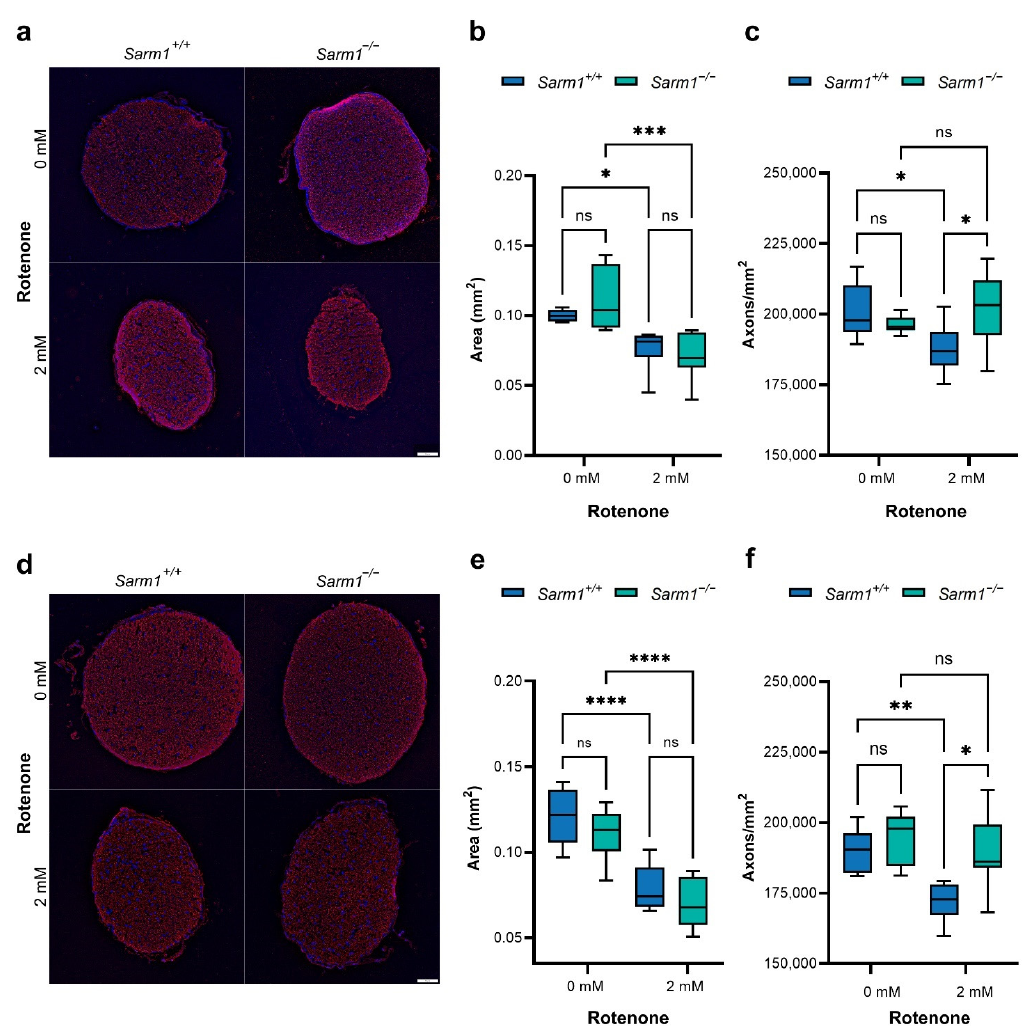
Figure 4. Quantification of axons. Two months after intravitreal injection of rotenone, eyes were enucleated, fixed and dissected. Optic nerves were cryosectioned (7 µ m) and stained for NF200 (red). Nuclei were stained with DAPI (blue). Segments of the proximal ( a ) and distal ( d ) optic nerve, the portion of the nerve nearest the eye and brain respectively, were sectioned and analysed separately. Scale bars ( a , d ) = 50 µ m. ( b , c , e , f ) Axons and optic nerve area were quantified using Olympus CellSens software. Optic nerves were thinner following rotenone insult in both genotypes ( n = 6–10), both close to the eye (( b ); Sarm1 +/+ 0.10 ± 0.004 mm 2 vs. 0.07 ± 0.02 mm 2 , p < 0.05; Sarm1 − / − 0.11 ± 0.02 mm 2 vs. 0.07 ± 0.02 mm 2 , p < 0.001) and brain (( e ) Sarm1 +/+ 0.12 ± 0.02 mm 2 vs. 0.08 ± 0.01 mm 2 , p < 0.0001, Sarm1 − / − 0.11 ± 0.02 mm 2 vs. 0.07 ± 0.01 mm 2 , p < 0.0001). Density of axons was protected in Sarm1 − / − optic nerves, with no significant difference between insulted and non-insulted sections from proximal (( c ) 201,631 ± 12,619 axons/mm 2 vs. 196,265 ± 3030 axons/mm 2 ) or distal (( f ) 188,764 ± 13,580 axons/mm 2 vs. 194,208 ± 9417 axons/mm 2 ) Sarm1 − / − optic nerves. There was a significant reduction in axonal density in wild type optic nerves receiving rotenone relative to both non-insulted Sarm1 +/+ and insulted Sarm1 − / − optic nerves ( n = 6–10; Proximal: rotenone-insulted Sarm1 +/+ 187,926 ± 7851 axons/mm 2 vs. uninjected Sarm1 +/+ 200,835 ± 9874 axons/mm 2 p < 0.05; rotenone-insulted Sarm1 +/+ 187,926 ± 7851 axons/mm 2 vs. rotenone-insulted Sarm1 − / − 201,631 ± 12,619 axons/mm 2 , p < 0.05. Distal: rotenone-insulted Sarm1 +/+ 172,002 ± 7086 axons/mm 2 vs. uninjected Sarm1 +/+ 190,789 ± 7402 axons/mm 2 , p < 0.01; rotenone-insulted Sarm1 +/+ 172,002 ± 7086 axons/mm 2 vs. rotenone-insulted Sarm1 − / − 188,764 ± 13,580 axons/mm 2 , p < 0.05). Error bars ( b – c , e – f ) represent SD values, * p < 0.05, ** p < 0.01 and *** p < 0.001, **** p < 0.0001, ns =